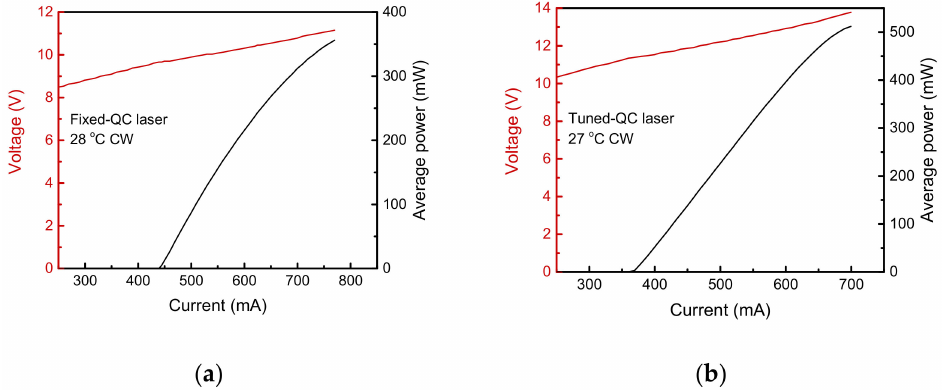
Figure 4. Continuous-wave current–voltage–light output characteristics of ( a ) the fixed quantum cascade (QC) laser operated at the heatsink temperature of 28 ◦ C and ( b ) the tuned QC laser operated at the heatsink temperature of 27 ◦